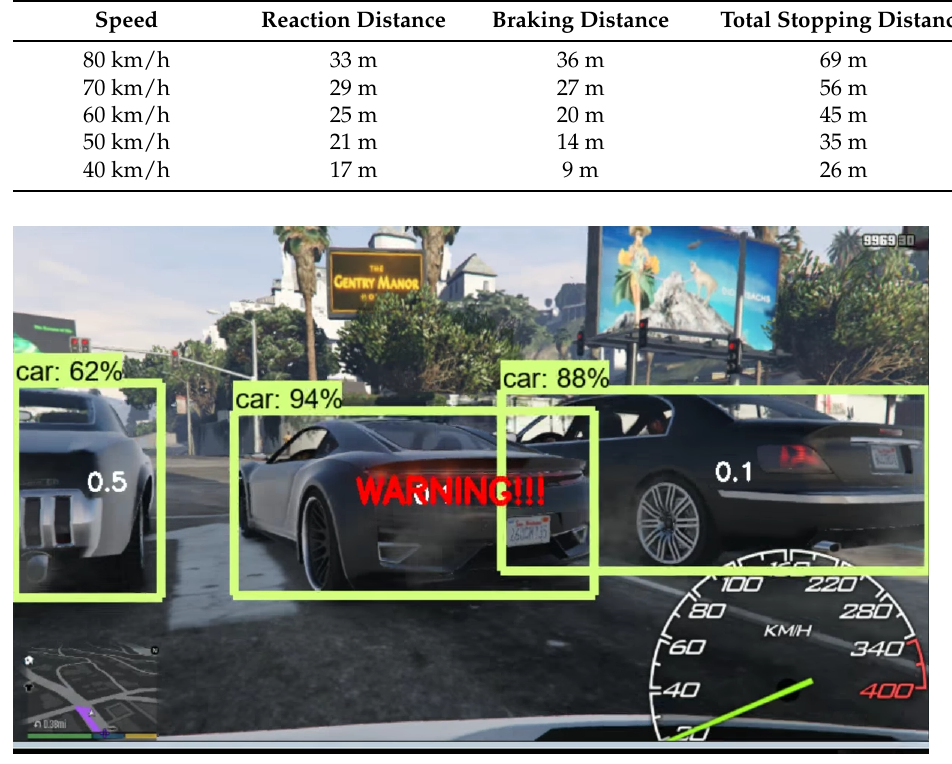
Figure 11. Braking situation in terms of distance calculation in GTA V